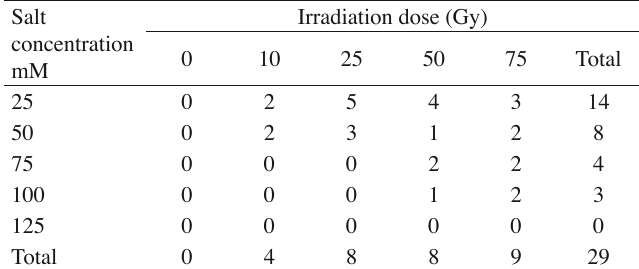
Table 2 - Effect of irradiation doses on the number of vigorous shoots of apricot cv. Canino, after six weeks from culturing in media containing different salt concentrations